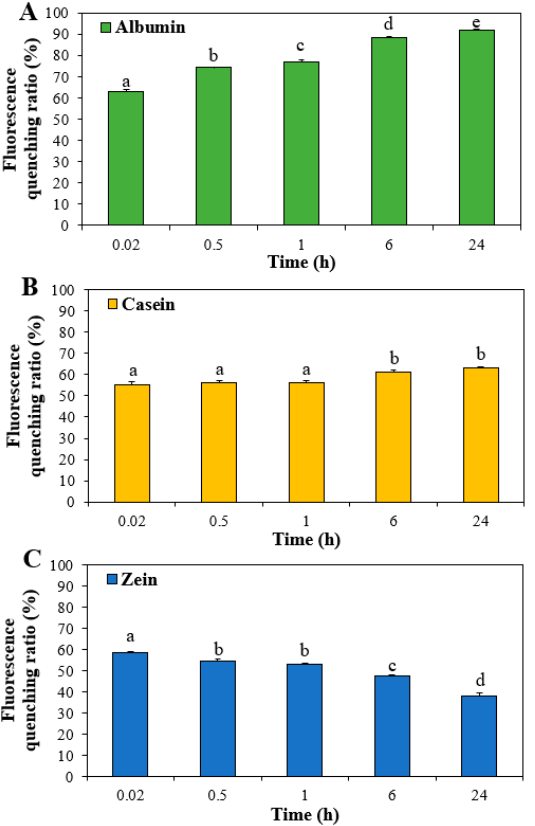
Figure 3. Fluorescence quenching ratios of ( A ) albumin, ( B ) casein, and ( C ) zein by interactions with ZnO NPs. Different lowercase letters (a,b,c,d) indicate significant differences among incubation times ( p < 0.05).